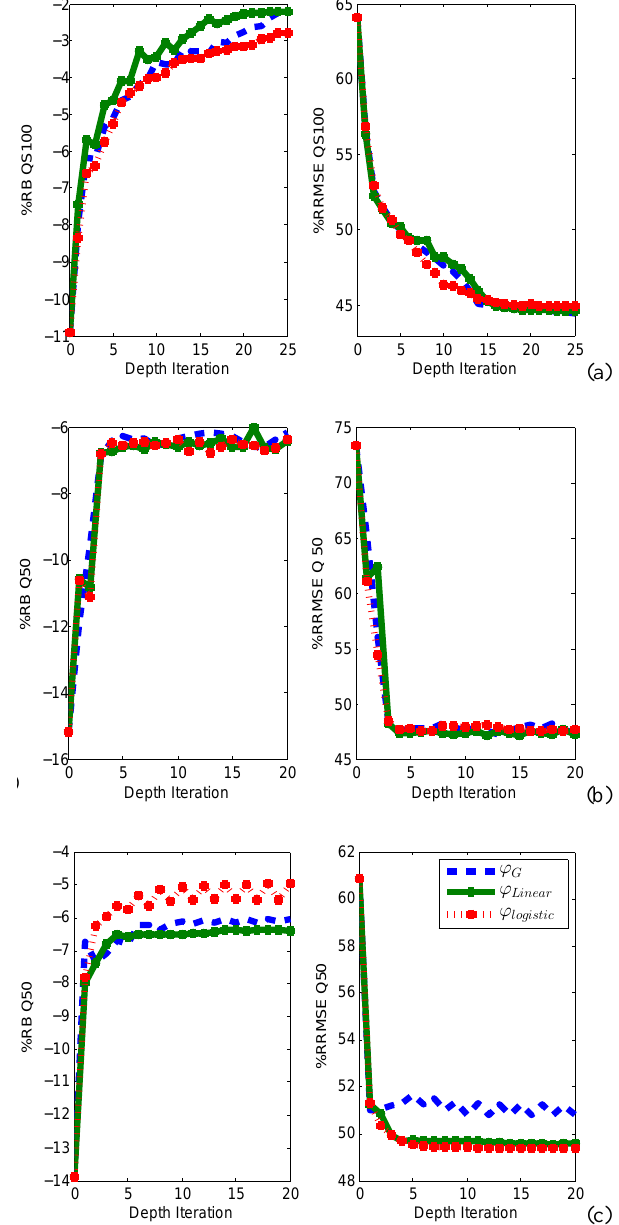
Fig. 7. Variation of criteria (RB and RRMSE) as a function of the depth iteration number for the estimation of (a) QS100 – southern Quebec, (b) Q50 – Arkansas and (c) Q50 –